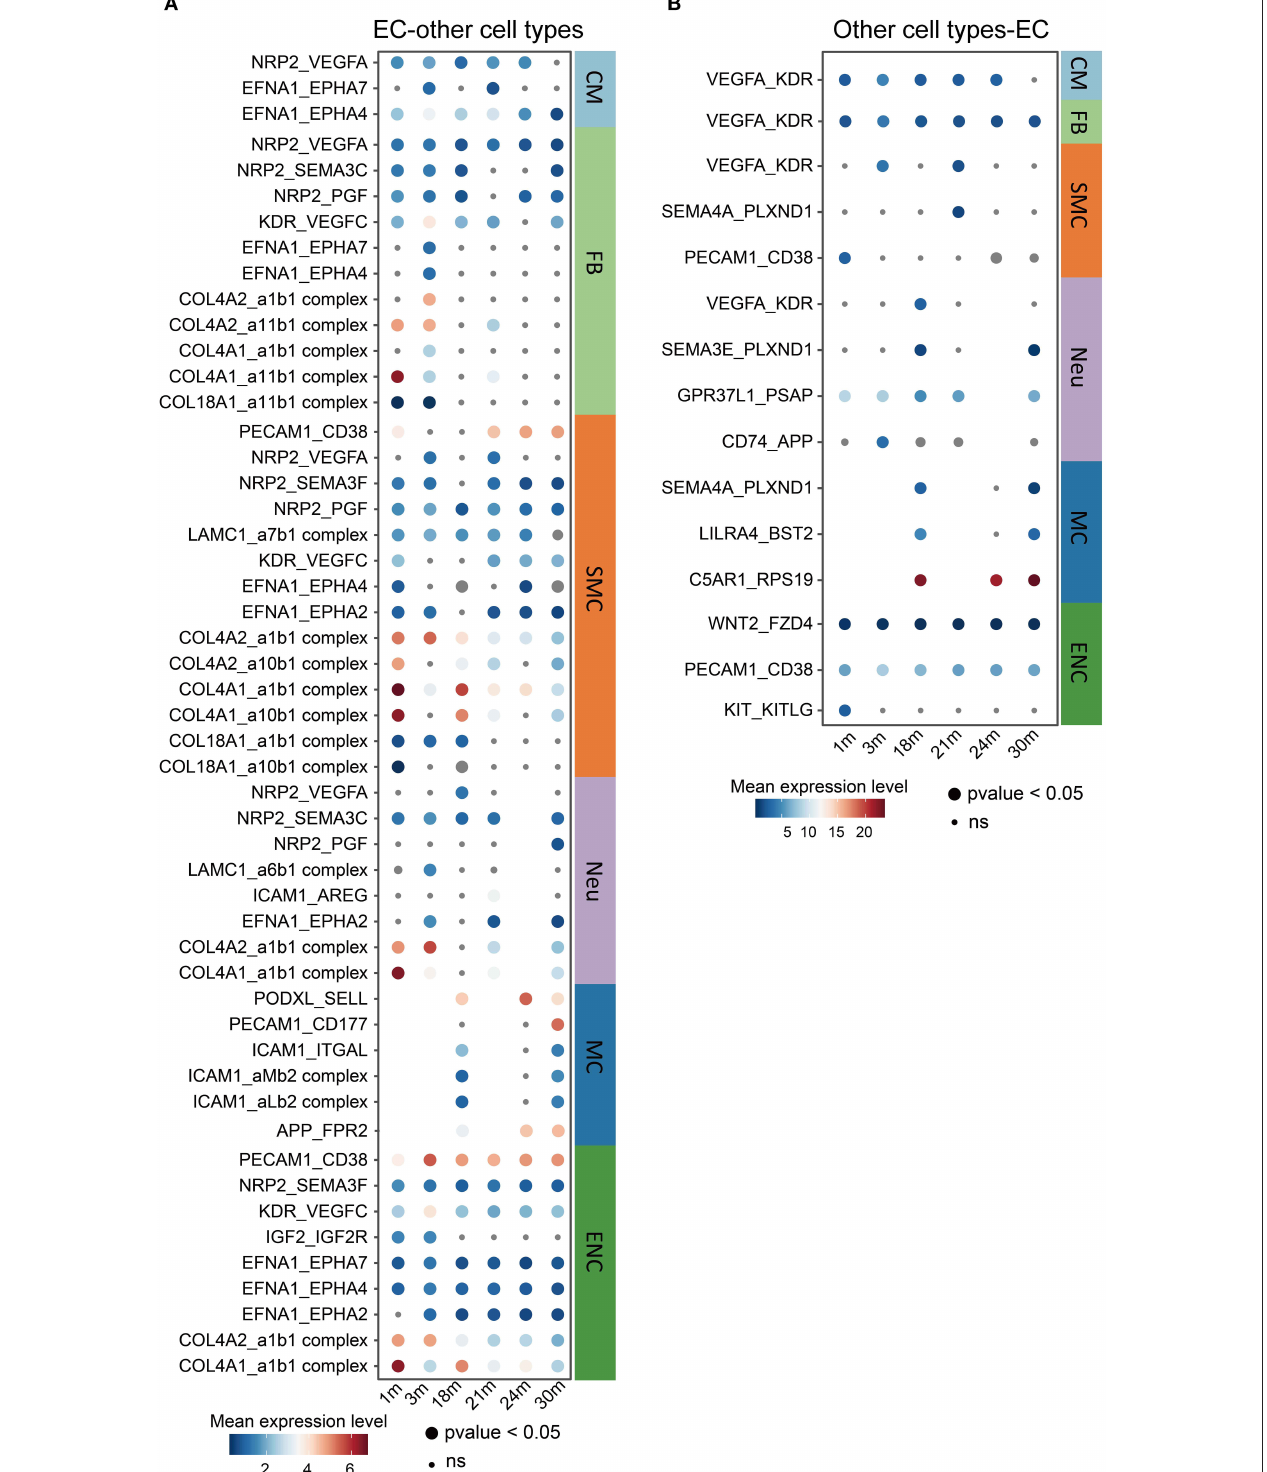
Frontiers in Cardiovascular Medicine |